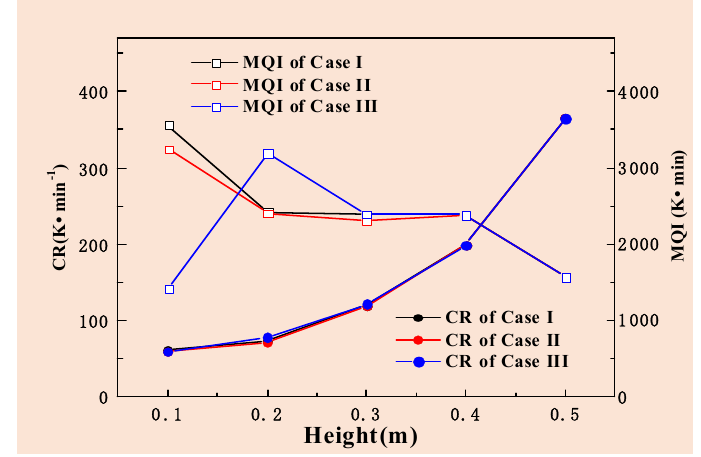
Figure 17. The heights of the upper and bottom beds mainly affected the MQI of the bottom bed. Compared with case I with equal upper and bottom bed heights, the MQI for the bottom bed shows a further decrease for case II, indicating that the issue on excessive heat was resolved. However, the MQI for case III at the position y = 0.1m was too low, which weakened the sinter strength in the bottom bed. In addition, the heights of the upper and bottom beds had little influence on CR based on our calculation. In summary, case II, with a 250 mm upper bed height and 350 mm bottom bed height, showed better results based on the FSDS calculation.